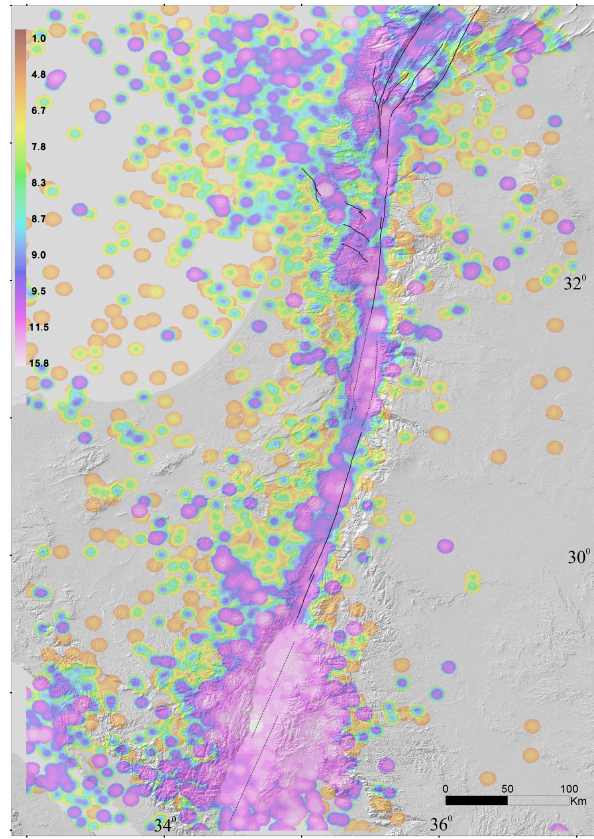
Figure 4. The seismic moment kernel density distribution, accord- ing to the relocated catalogue. Colours and corresponding numbers indicate the value in log(Jkm − 2 yr − 1